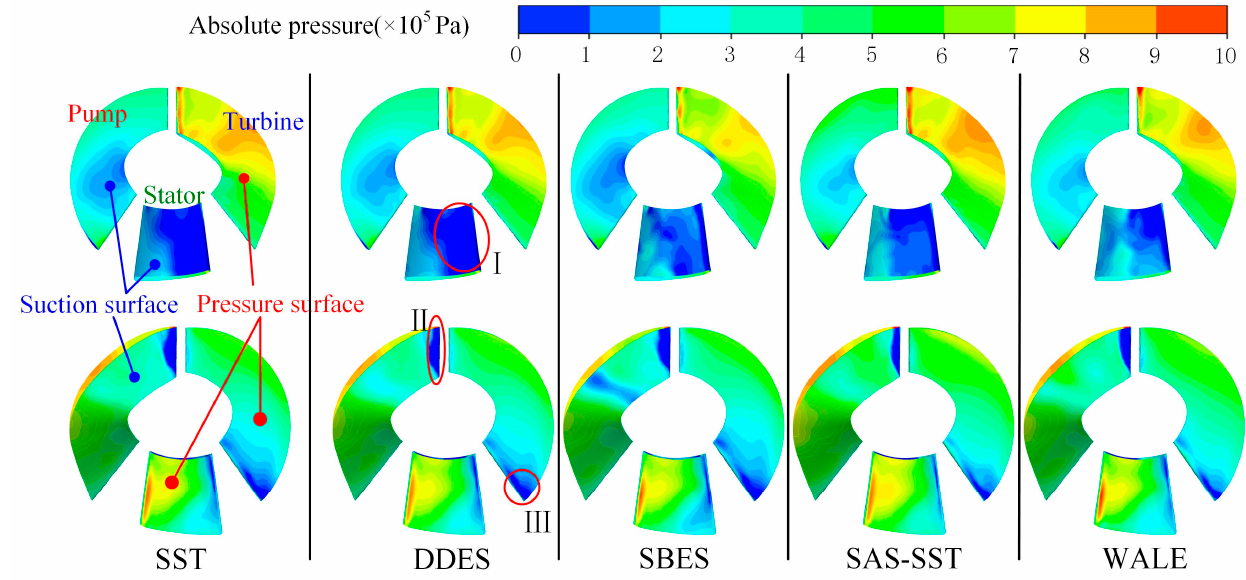
Figure 17. Distribution trend of absolute pressure on blades under various models. (I) Cavitation zone on stator blade surface, (II) cavitation zone on turbine blade surface, (III) cavitation zone on pump blade surface.